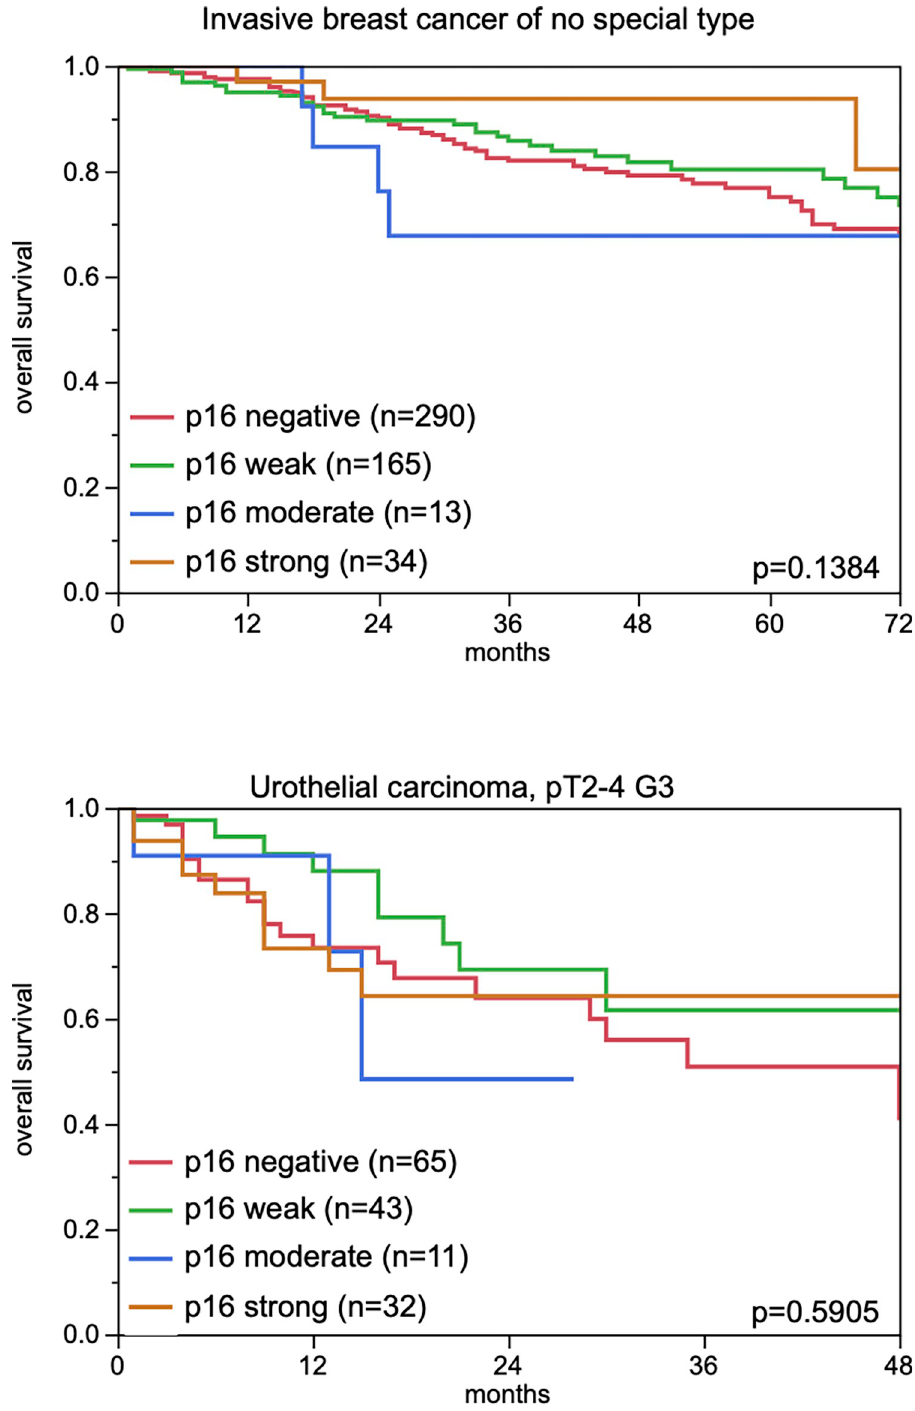
Fig 4. p16 immunostaining and overall survival in patients with invasive breast cancer of no special type and urothelial carcinoma (pT2-4; G3). � The numbers do not add to the total number of tumors with clinical follow-up data, since only cases with evaluable p16 staining are